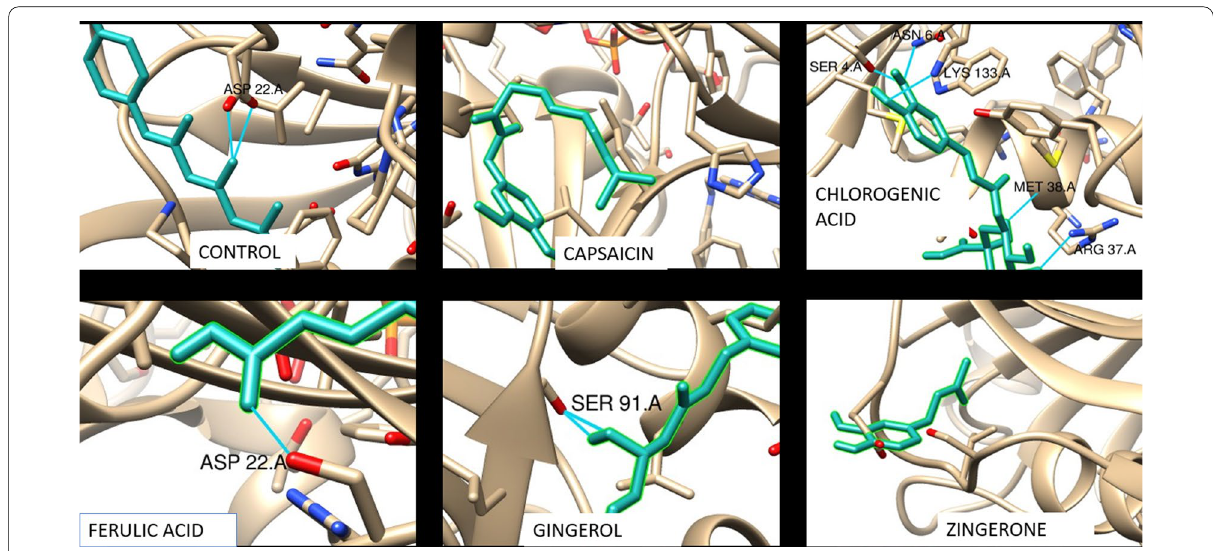
Fig. 6 Docked pictures of curcumin analogues and proguanil (control) against human DHFR receptor. (Ligand represents the blue sticks, hydrogen bond interaction is represented in blue line, and receptor is represented in solid white ribbon